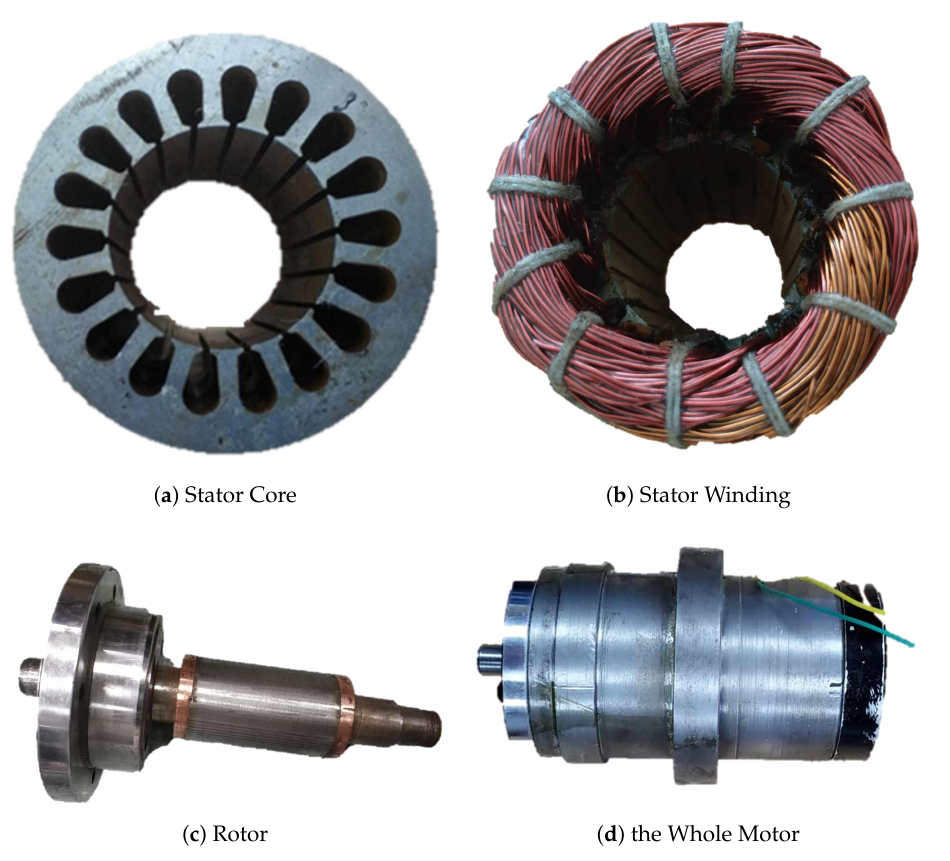
Figure 16. Prototype of the